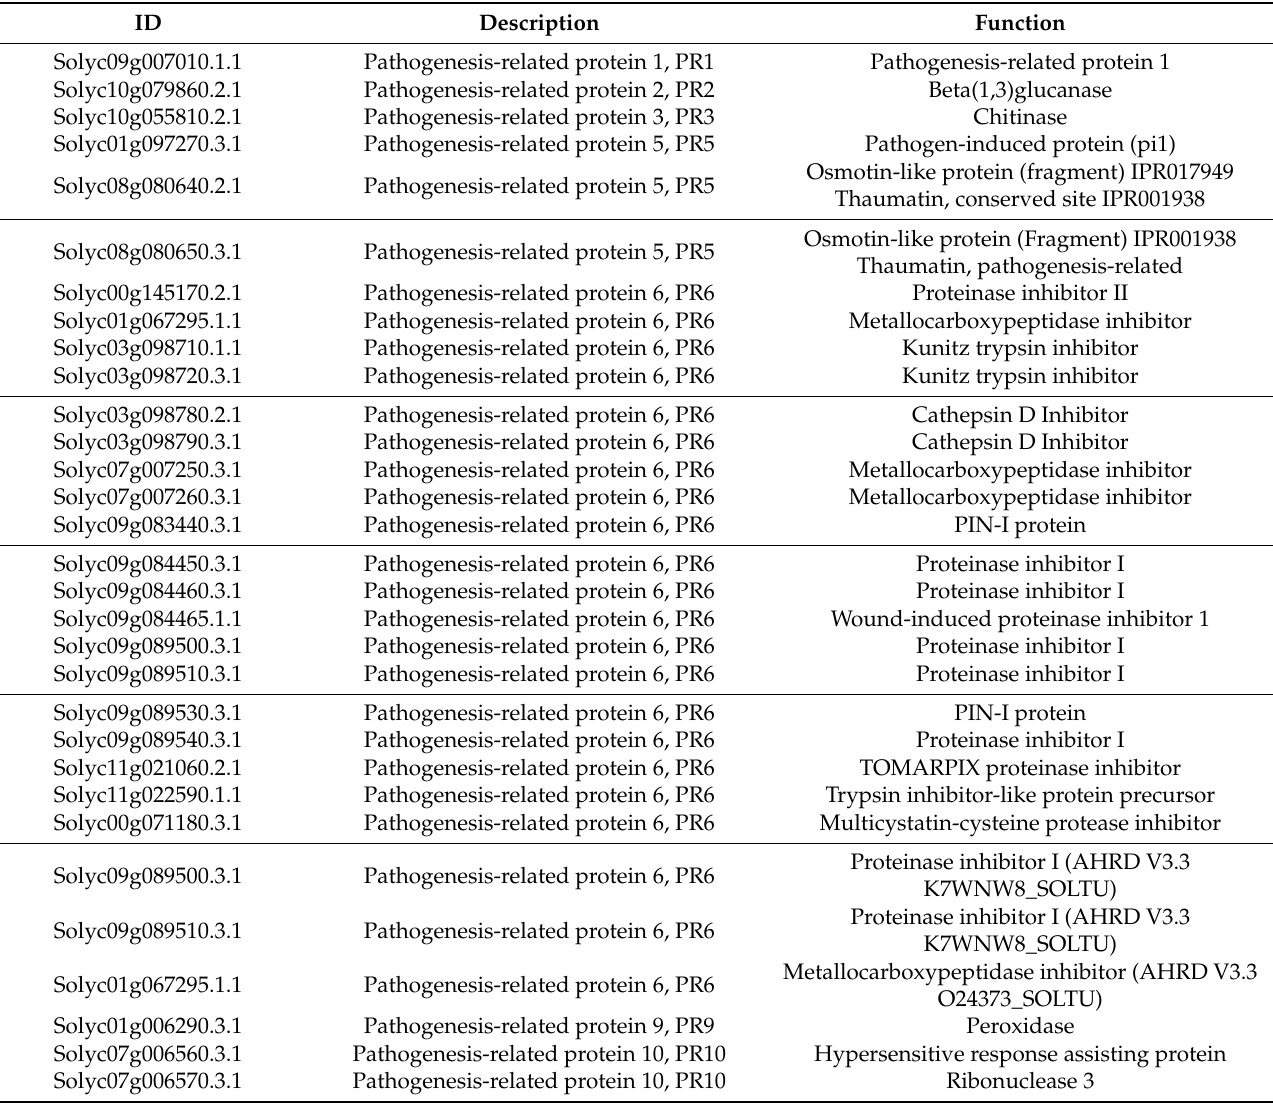
Table 2. Pathogenesis-related proteins identified in